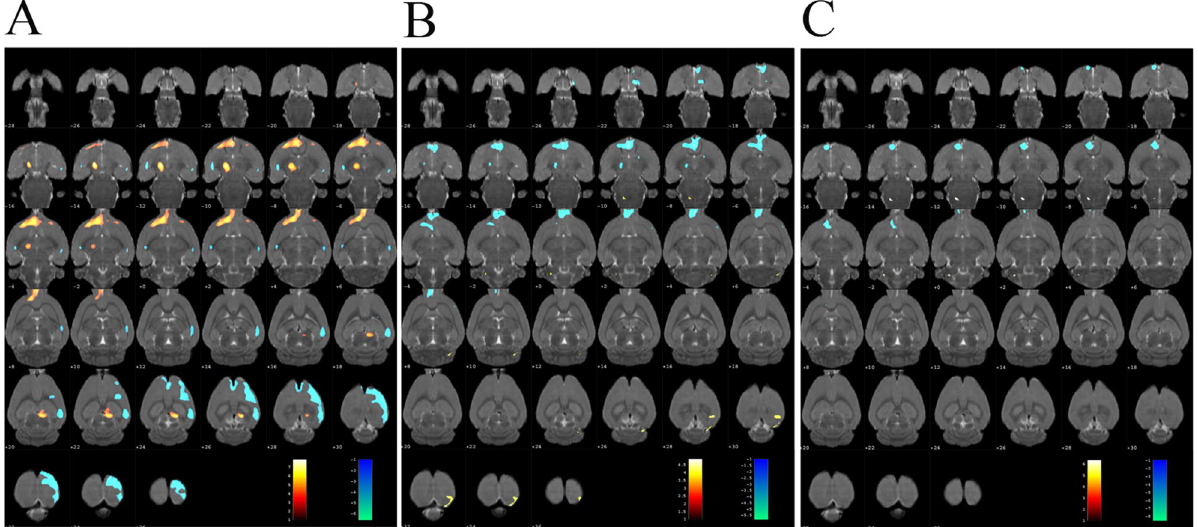
Figure 2. Changes of glucose metabolism in the rat brain. Regional glucose metabolism was scanned after the 7-day treatment. Results are overlaid on an axial view of the rat brain and mapped to the Paxinos and Watson rat brain atlas. ( A ) SHR group versus WKY group, ( B ) MA group versus SHR group, ( C ) Sham-MA group versus SHR group. Color bars represent the t-value of each significant